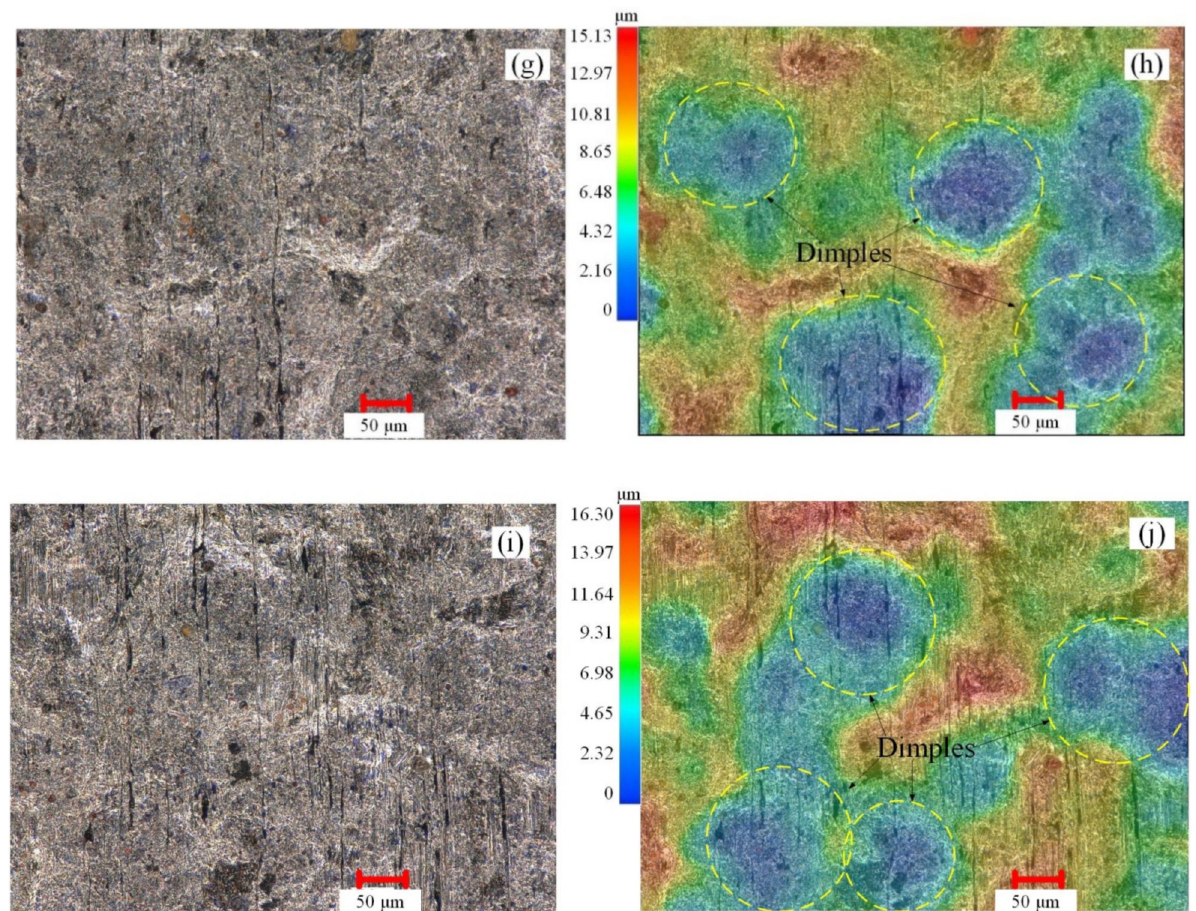
Figure 15. The specimen surface graph of ( a ) P1, ( c ) P2, ( e ) P3, ( g ) P4 and ( i ) P5 and the processed 2D topography of ( b ) P1, ( d ) P2, ( f ) P3, ( h ) P4 and ( j )